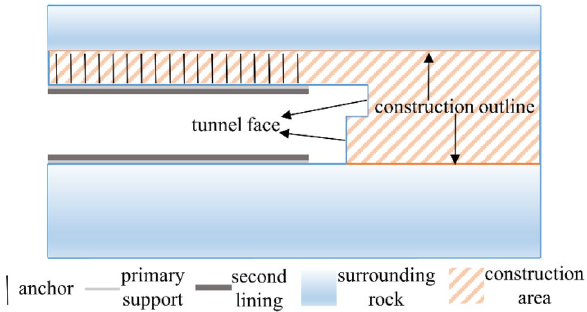
Figure 1. The tunnel construction diagram.